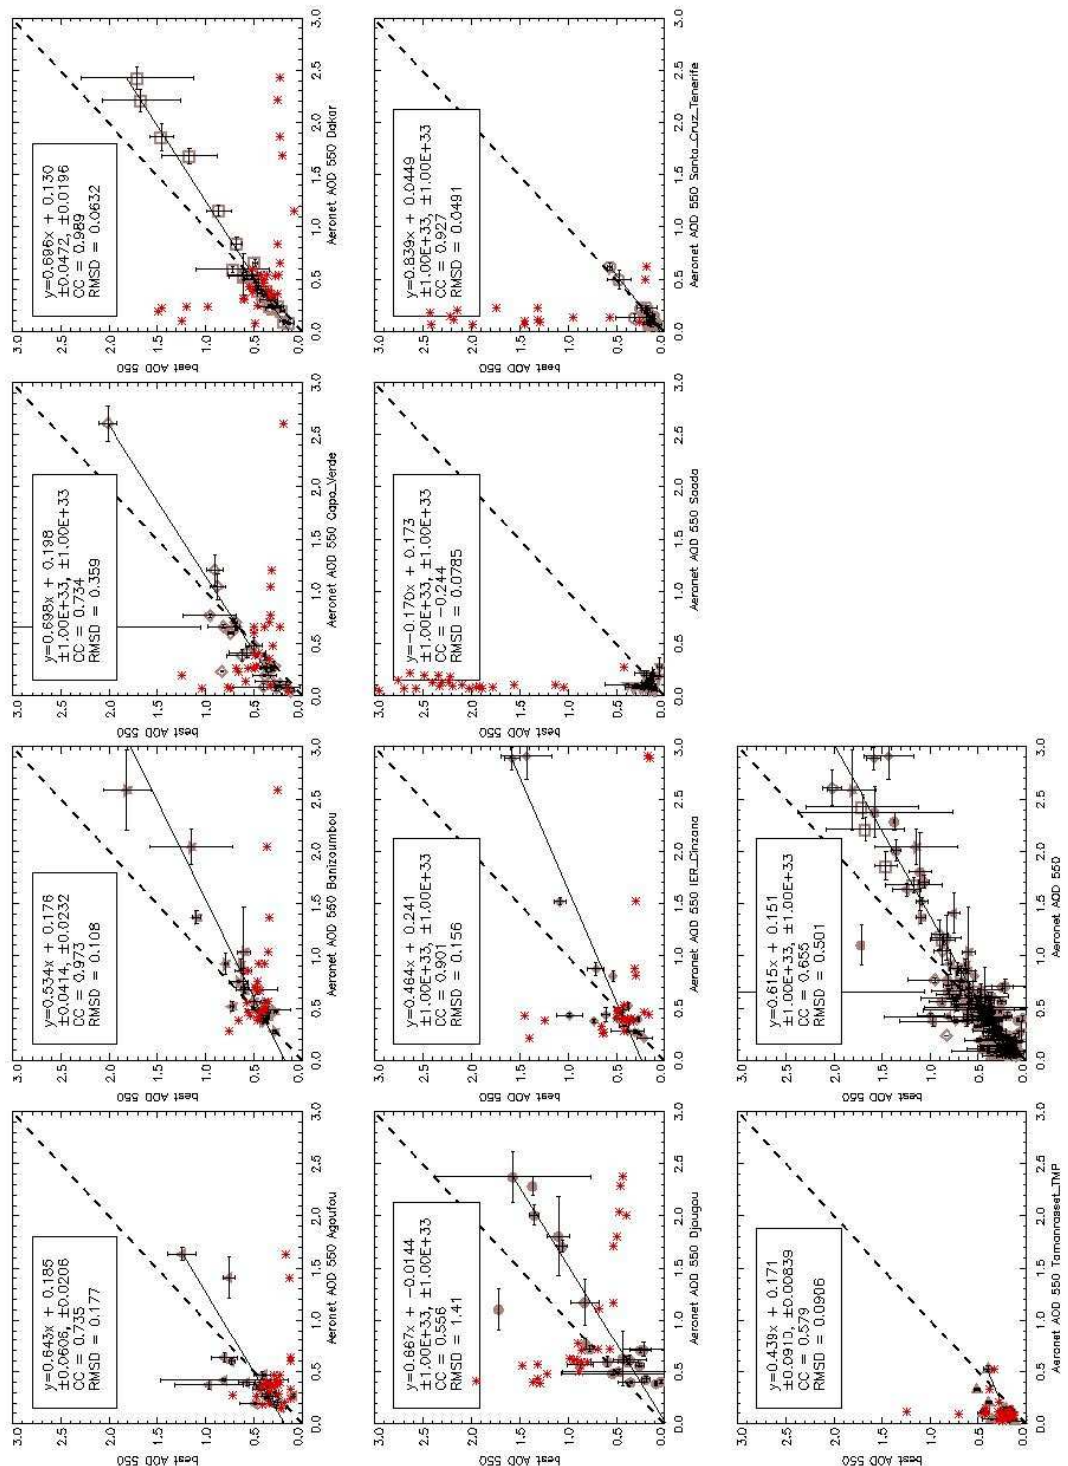
Fig. 12. Combined daily AOD vs. AERONET. Equivalent of Fig. 4 but obtained considering the combined AOD instead of a single satellite dataset. Different locations are shown in different plots and are represented by different symbols, as with Fig. 3. The red stars represent two times the AERONET ˚Angstr¨om coefficient (between 440 and 870nm). The final plots show all the coincidences.